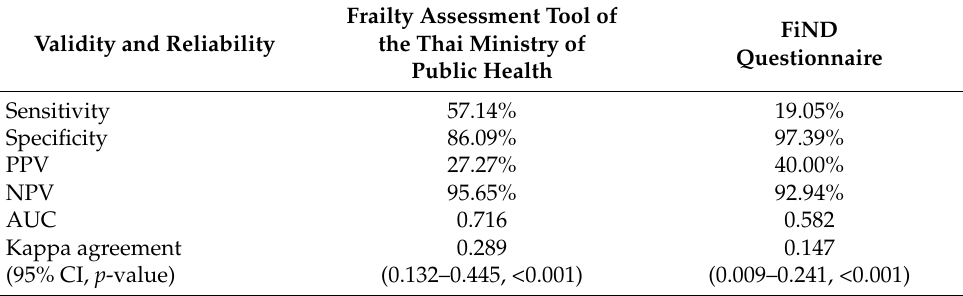
Table 5. Sensitivity, specificity, positive predictive value (PPV), negative predictive value (NPV), and Cohen’s kappa of the Frailty Assessment Tool of the Thai Ministry of Public Health and FiND